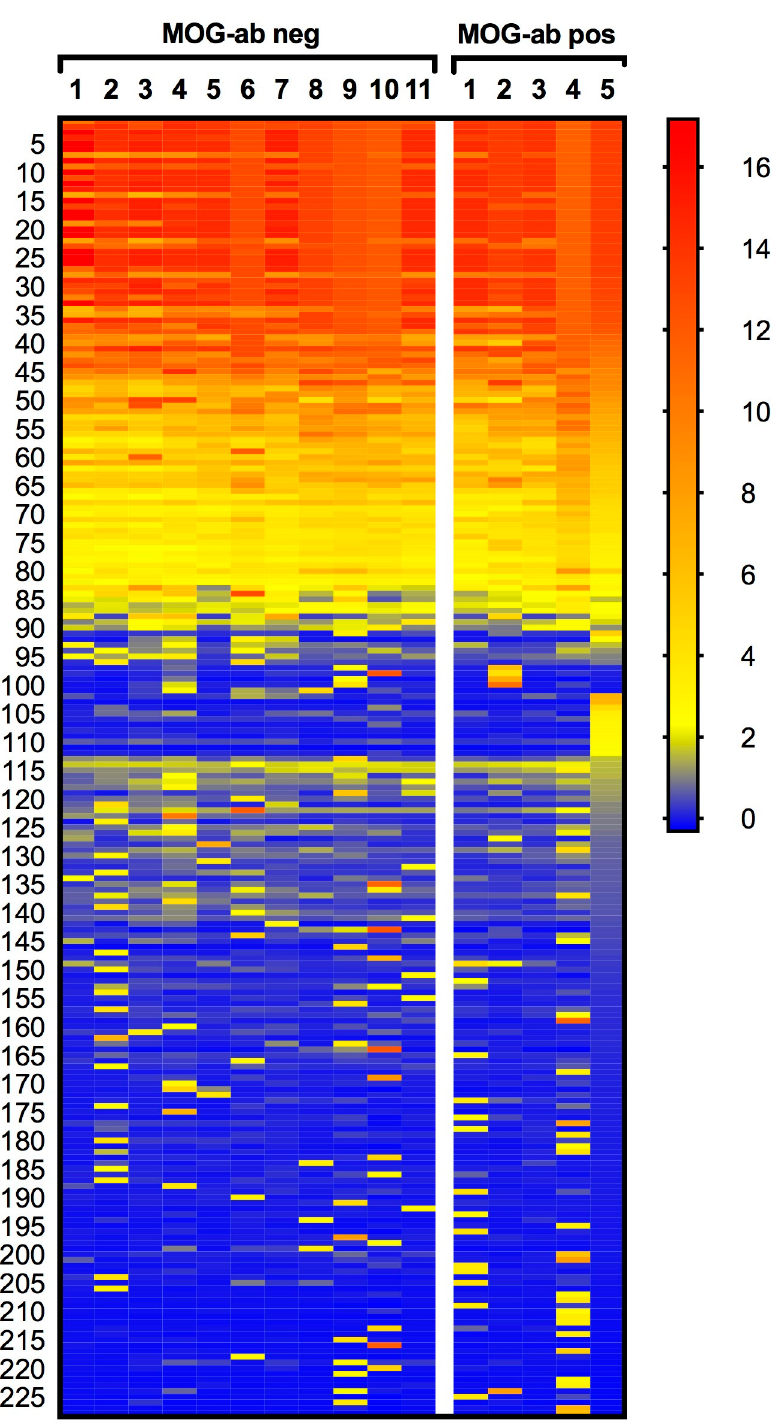
Figure 1. Heatmap of 228 proteins (see Table S1) with significant hits (z-score ≥ 2.33) in at least one serum sample. Columns are individual serum samples from myelin oligodendrocyte glycoprotein antibody (MOG-ab) negative (neg, n = 11) and positive (pos, n = 5) acute disseminated encephalomyelitis (ADEM) patients; rows are proteins with a z-score ≥ 2.33. Values range from blue ( − 0.32) to yellow (2.33) to red (17), with a legend on the right side.